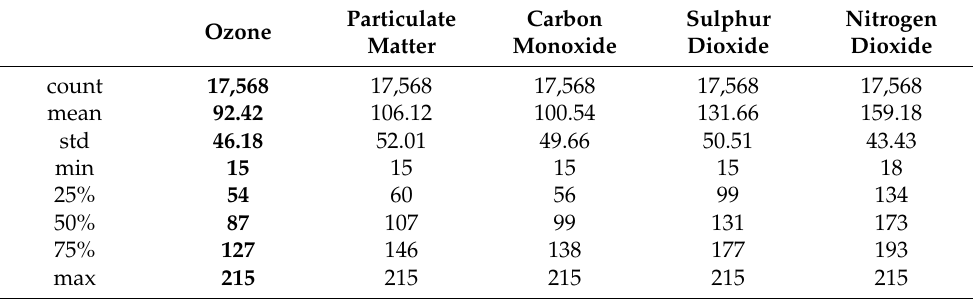
Table 2. Description of the dataset pollution measurements.